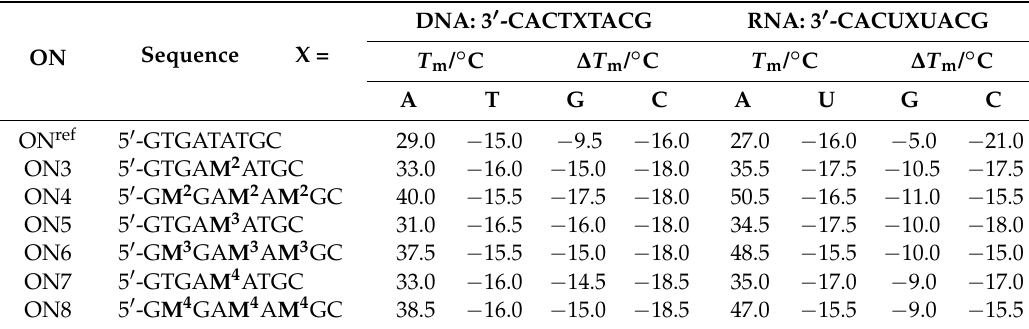
Table 2. Thermal denaturation temperatures of mismatched duplexes a